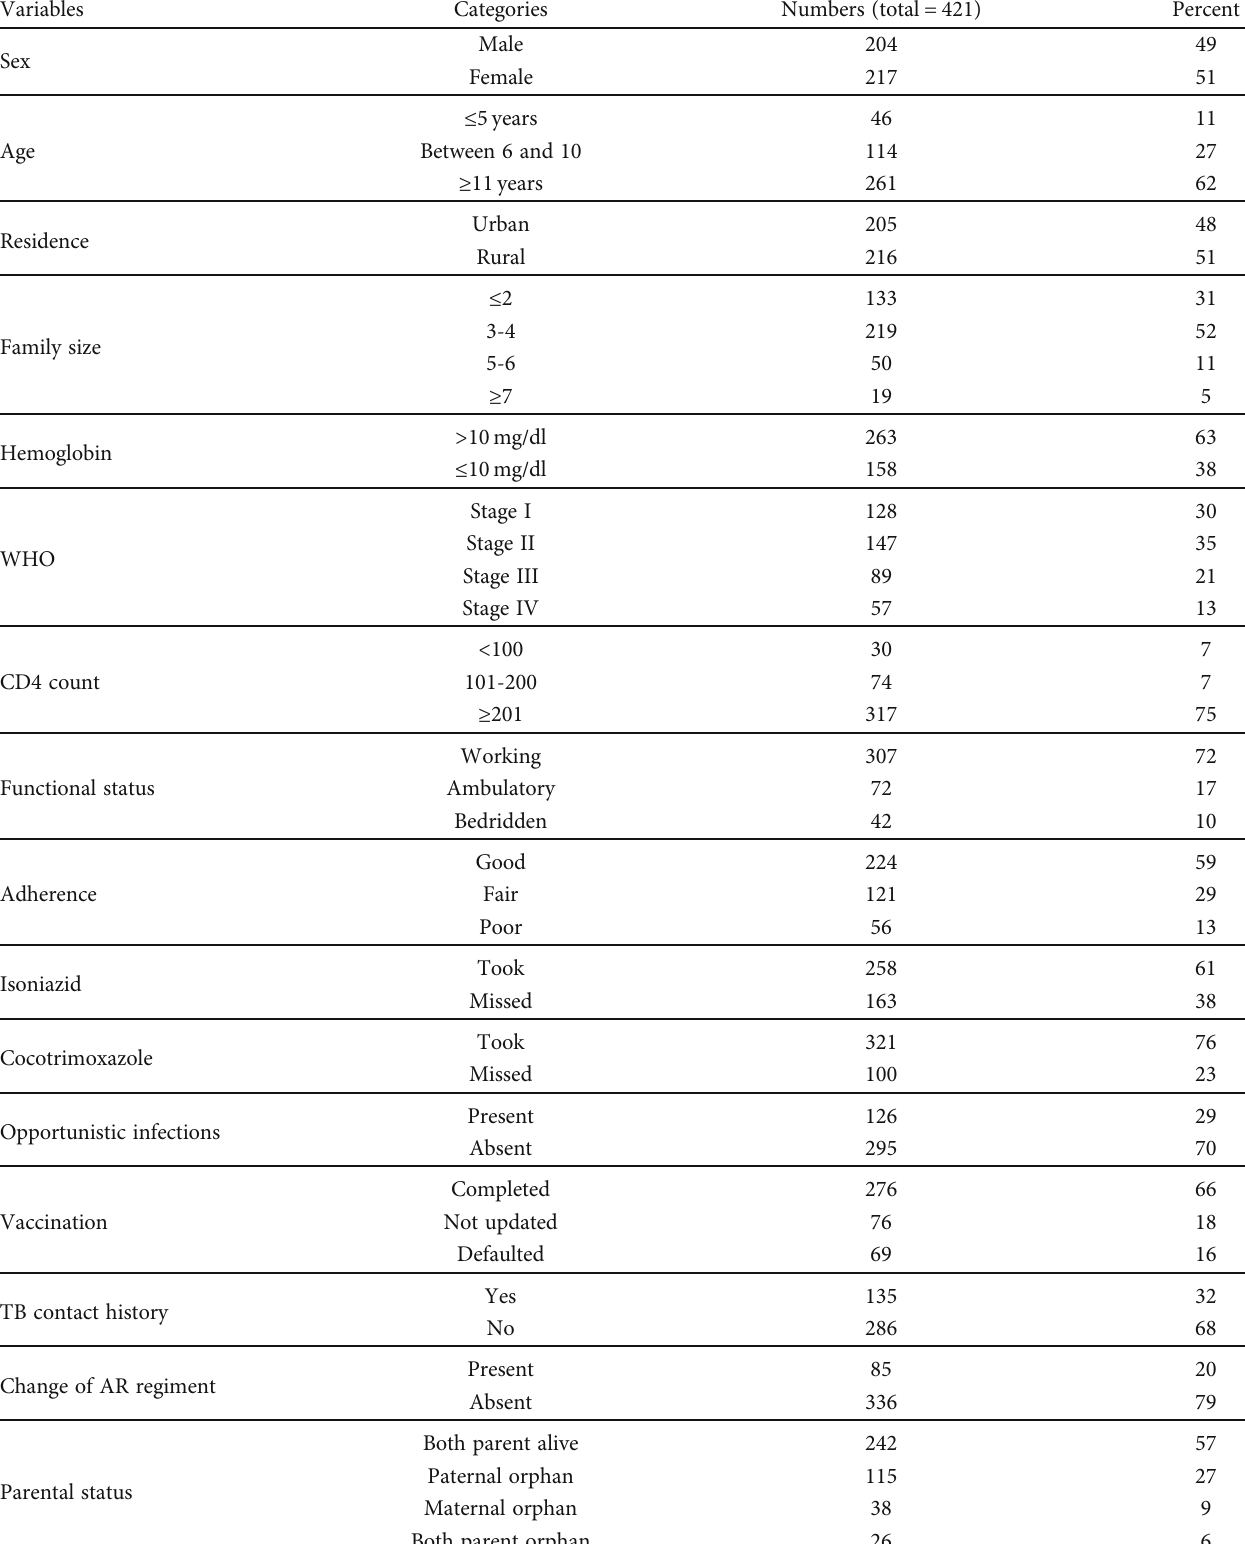
Table 1: Baseline sociodemographic, clinical, and laboratory characteristics of children received ART in two public hospitals ( between = 2009 and2018